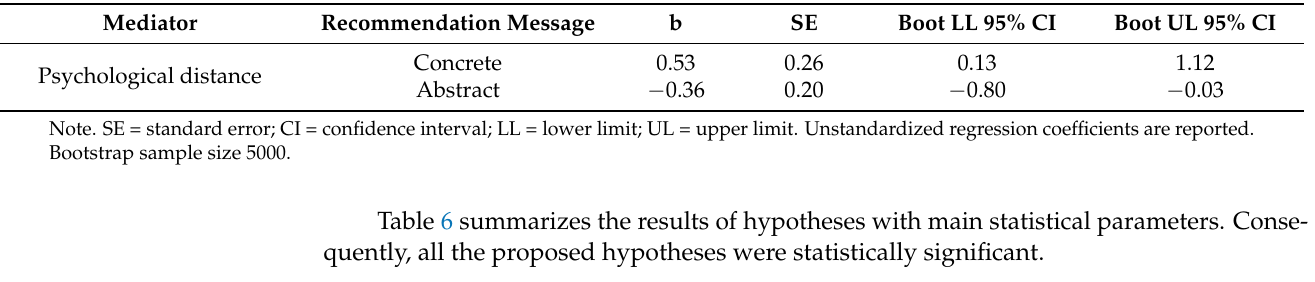
Table 5. Conditional indirect effect of psychological ownership for attitude toward content information through psychological distance moderated by recommendation message.